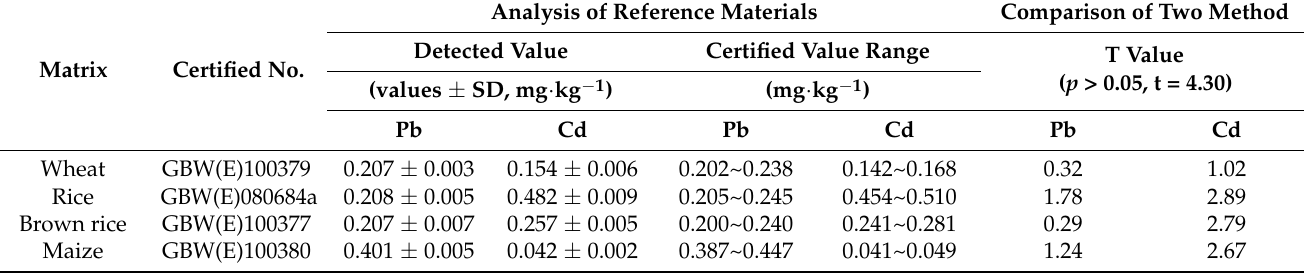
Table 5. Trueness study of the method (n = 3).